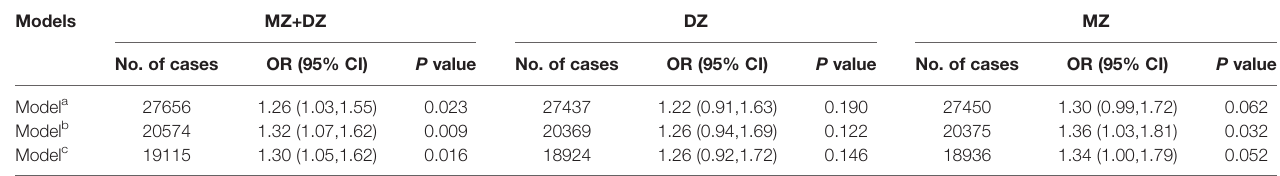
TABLE 4 | Differences in ORs (95% CIs) for the unmatched GEE models and matched co-twin control analyses (the difference in overweight or obesity between unmatched and co-twin matched controls).